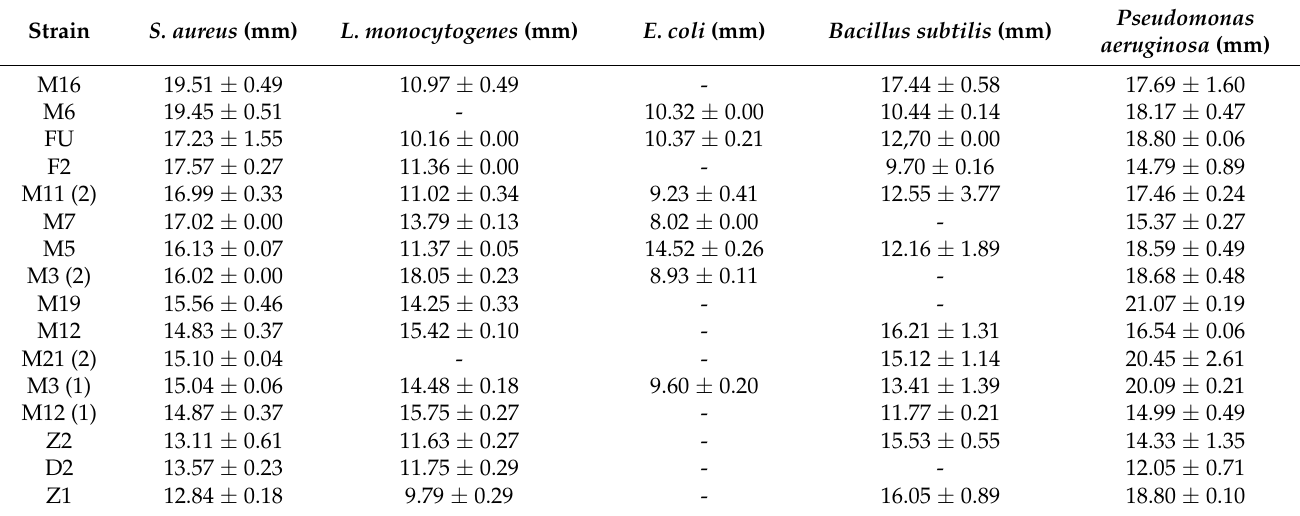
Table 4. Inhibition results of the screened LAB (top 16 strains).